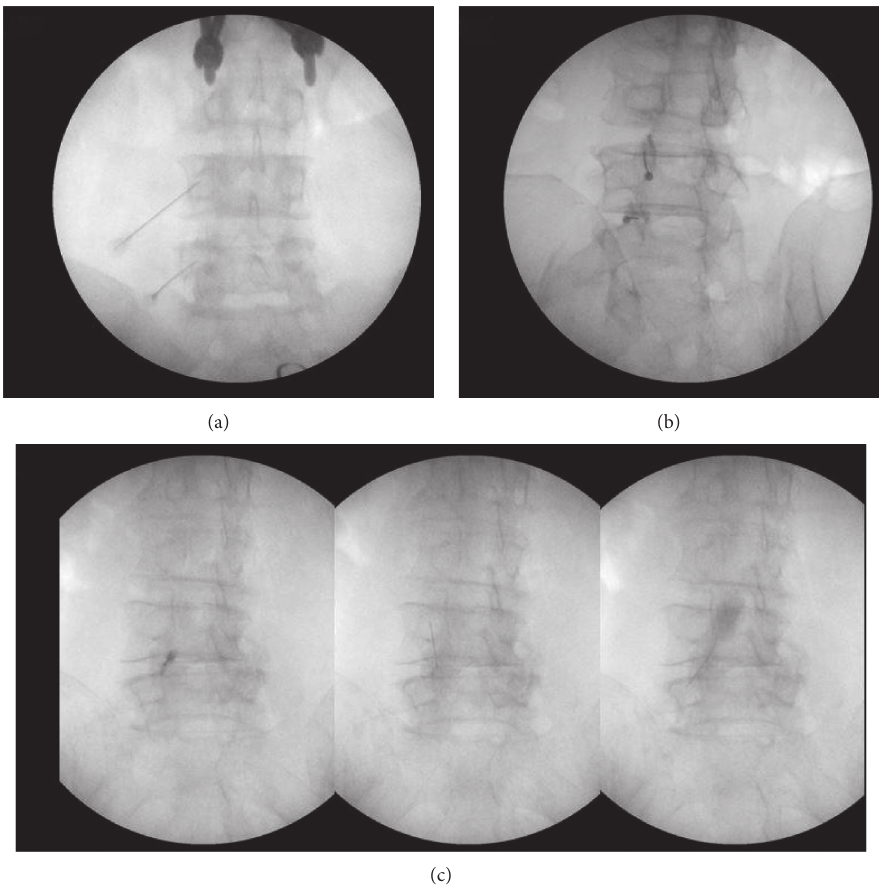
Figure 1: C-arm image intensifier view of MBB, FJI, and combined treatment with MBB and FJI: (a) MBB for nerves innervated into the left L4-5 facet joint, (b) FJI for the left L3-4 and L4-5 facet joints, and (c) combined treatment with MBB and FJI for the left L4-5 facet joint. MBB, medial branch block; FJI, facet joint